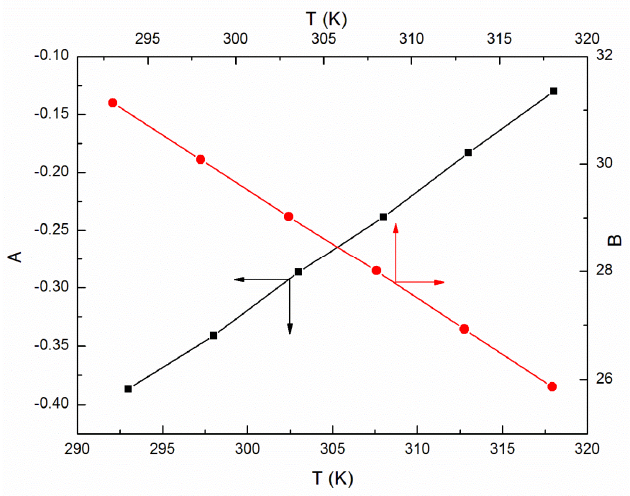
Figure 8. A plot of the values of A and B coefficients determined from the Jones–Dole equation and viscosity of the aqueous solutions of ELP vs. T.